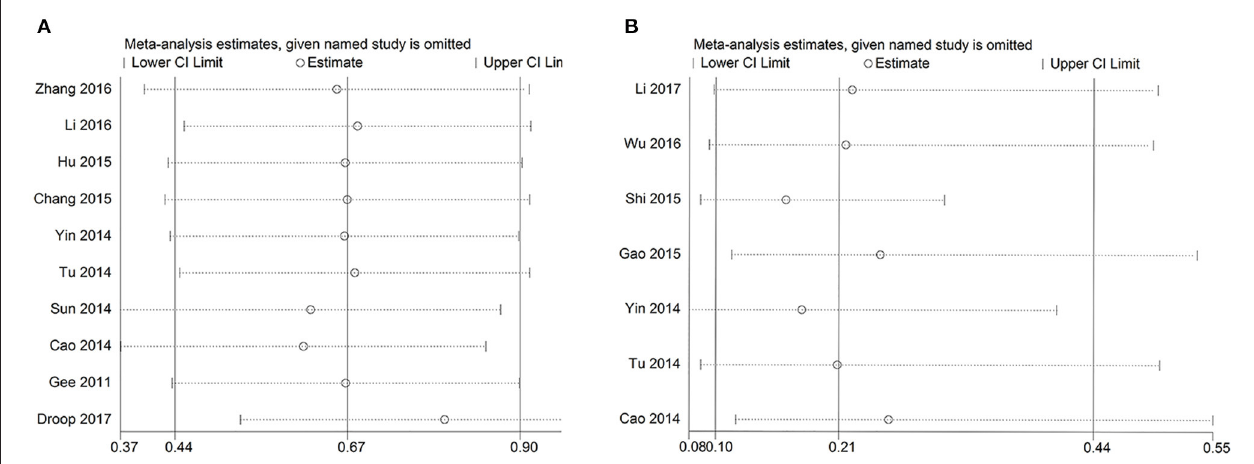
FIGURE 5 | Sensitivity analysis of OS and LNM. (A) Sensitivity analysis of effect of individual studies on the pooled HRs for GAS5 and overall survival of patients. (B) Sensitivity analysis of effect of individual studies on ORs for GAS5 and lymph node metastasis of patients.